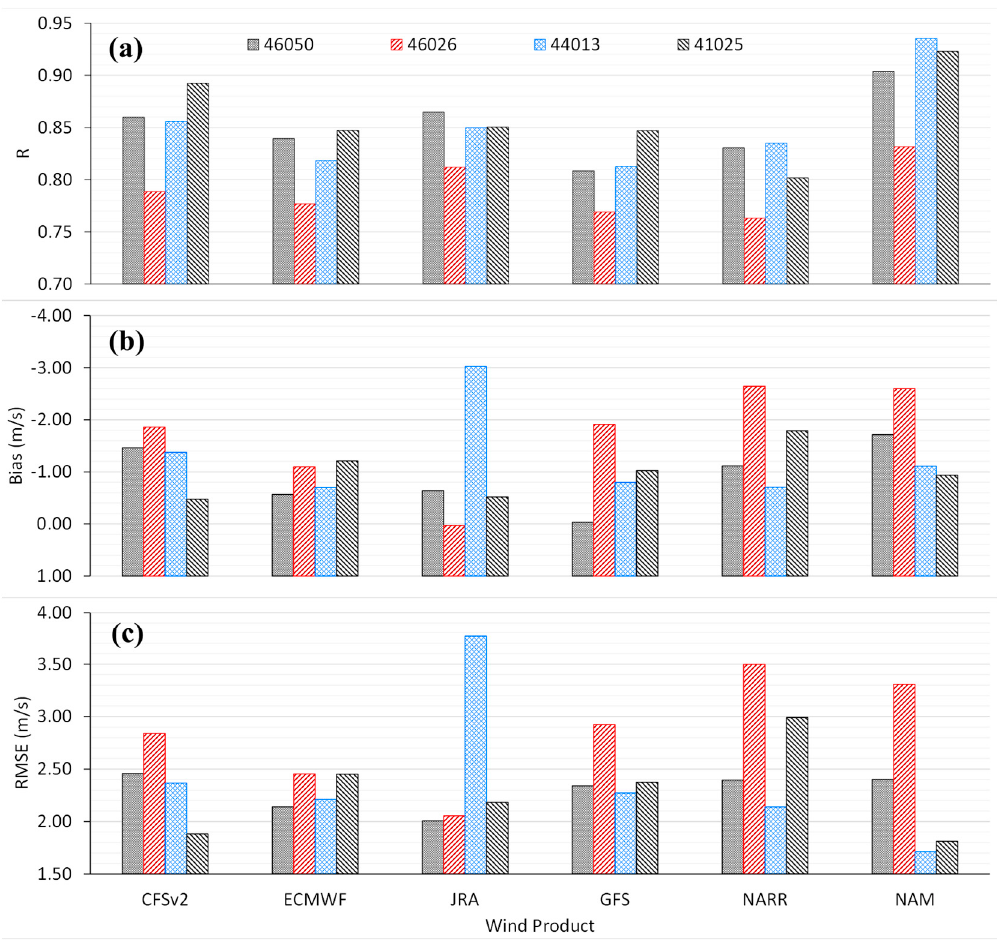
Figure 3. Performance statistics of three representative parameters (( a )—R; ( b )—bias; and ( c )—RMSE for all six wind products evaluated in this study. The correlation coefficient, R, is calculated at the significance level of α = 0.05 throughout this study.